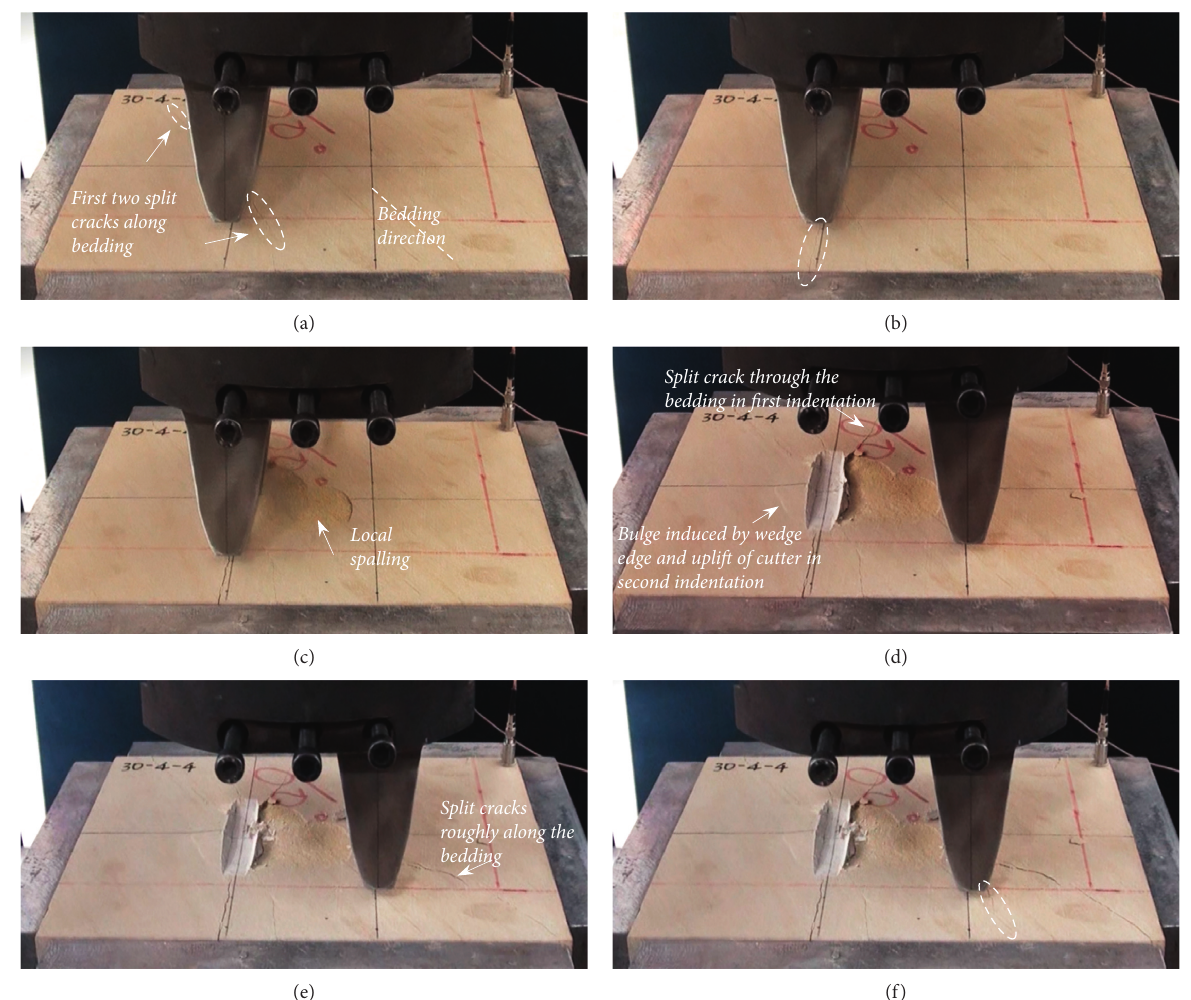
Figure 9: Surface crack evolution of the α � 30 ° specimen under 4MPa hydrostatic